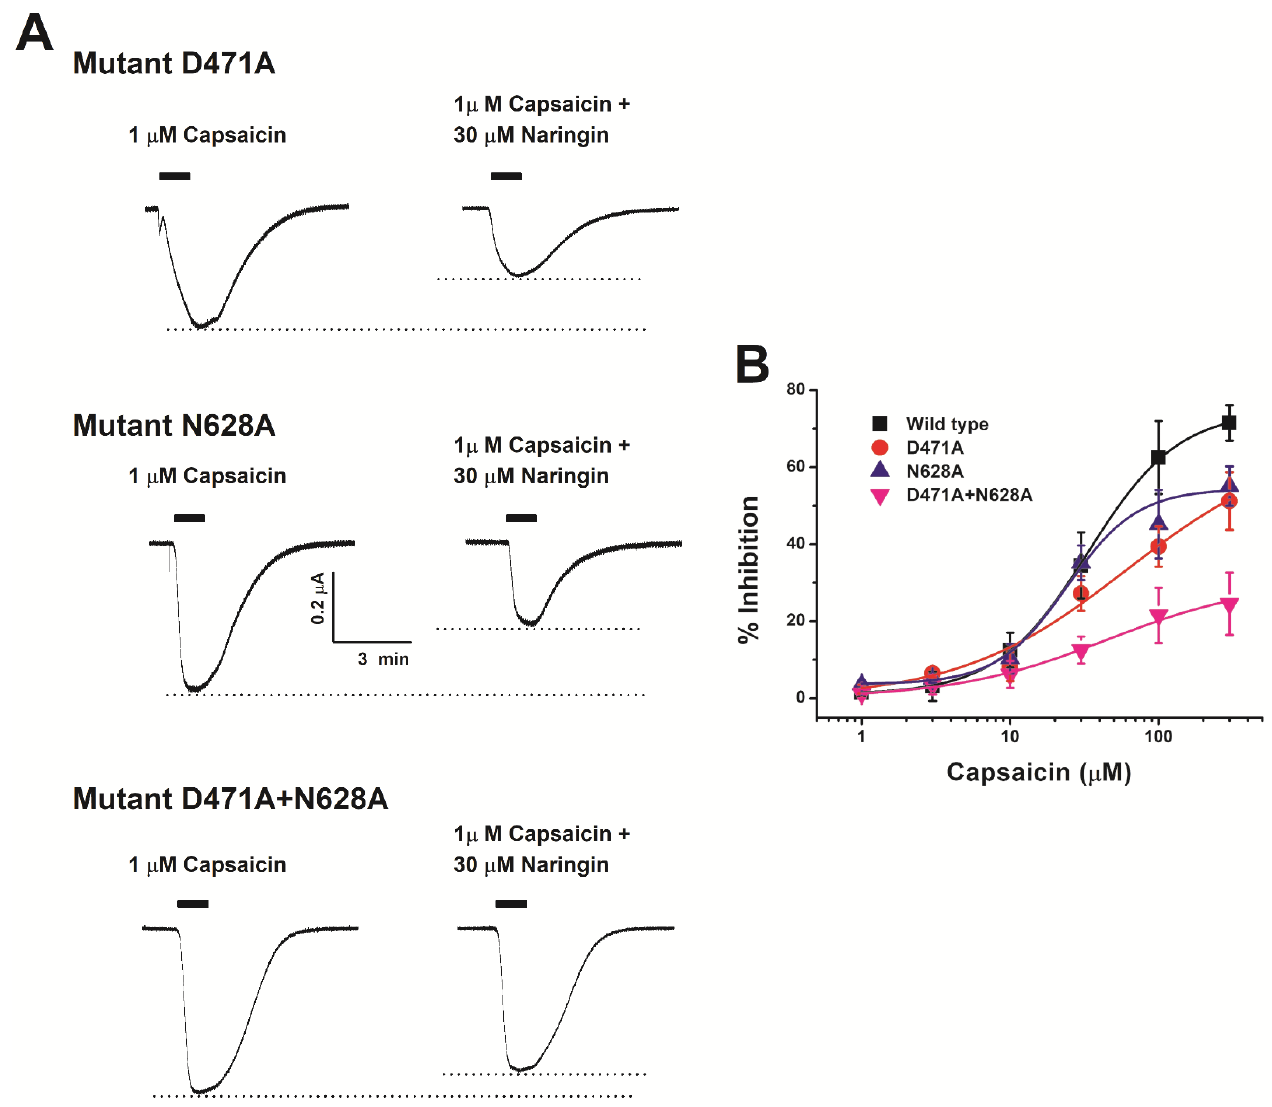
Figure 6. Comparison of the effect of naringin on mutant TRPV1: ( A ) D471A mutant TRPV1 was co-treated with naringin (30 µ M) and capsaicin (1 µ M). D471A mutant group was injected only with D471A TRPV1 mRNA into oocytes. N628A mutant TRPV1 was co-treated with naringin (30 µ M) and capsaicin (1 μM). N628A mutant group was only injected with N628A TRPV1 mRNA into oocytes. D471A + N628A mutant group was injected with both D471A and N628A TRPV1 mRNAs into oocytes. ( B ) Concentration-response curves for the effect of naringin on oocytes expressing mutants. The percent inhibition of I cap on each mutant was normalized based on the peak inward current induced by capsaicin and that of the peak inward current elicited by capsaicin plus naringin. Each point showed the mean ± S.E.M. ( n = 9 – 14 from six different frogs). Additional half inhibitory concentration, Hill coefficient, and Imax values are described in Results.